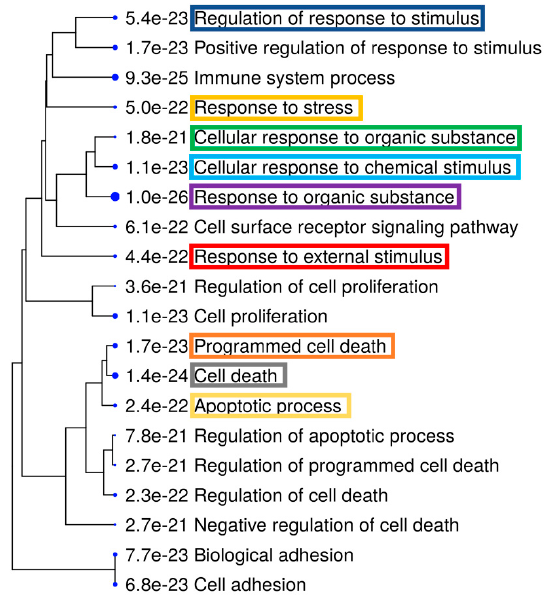
Figure 7. Enriched biological processes after treatment of hTCEpi cells with AC EFs for 24 h. Sig- nificantly enriched biological processes following analysis of the antibody array data are high- lighted as an interactive hierarchical clustering tree using ShinyGO. Biological processes with many shared genes are clustered together. Bigger dots indicate more significant p -values. Enriched biological processes that were similar after analysis of both gene and protein array data are marked and highlighted. Analysis was performed using ShinyGO (v.0.61) (Available online: http://bioinformatics.sdstate.edu/go/ (accessed 6 January 2021 )).